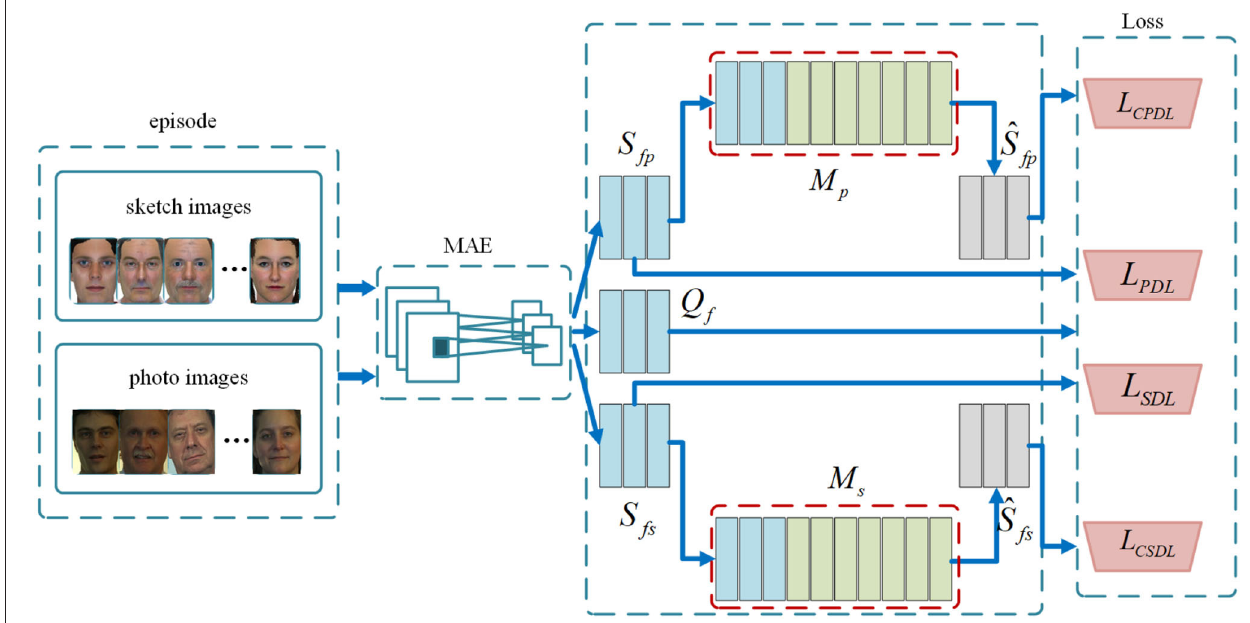
FIGURE 1 | Cross task modality alignment network (CTMAN) for sketch face recognition. In each training episode, CTMAN first embeds sketch and photo images into feature space by modality alignment embedding (MAE) network to obtain query feature set Q f and support feature set ( S fs and S fp ). Then, it proposes two cross task memory mechanism M p and M s to obtain the cross task support feature set ( ˆ S fs and ˆ S fp ). Finally, a cross task modality alignment loss ( L CPDL + L CSDL ) is computed on the query feature set and cross task support feature set, a modality alignment loss ( L PDL + L SDL ) is computed on the query feature set and the support feature set, and the final loss is computed over the cross task modality alignment loss and modality alignment